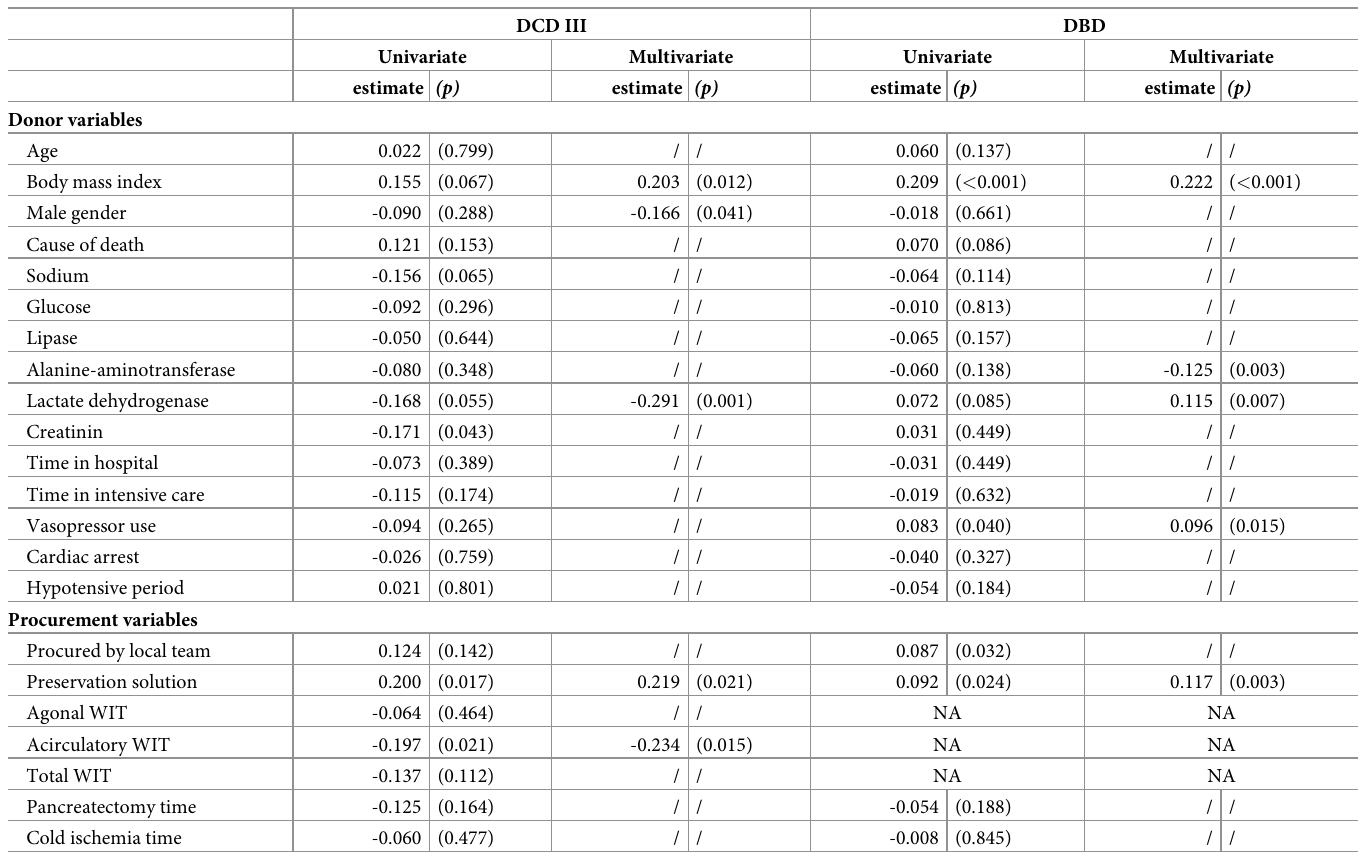
Table 3. Correlations of donor and procurement variables with beta cell yield in islet cell